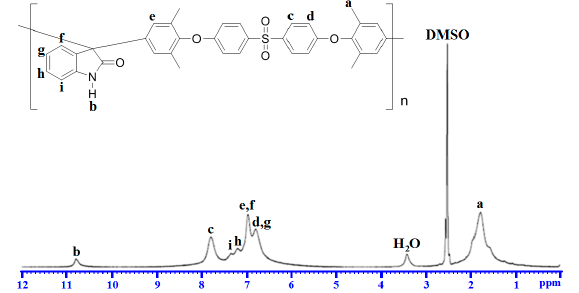
Figure 2. 1 H NMR of poly(isatin-ethersulfone) (PIES).